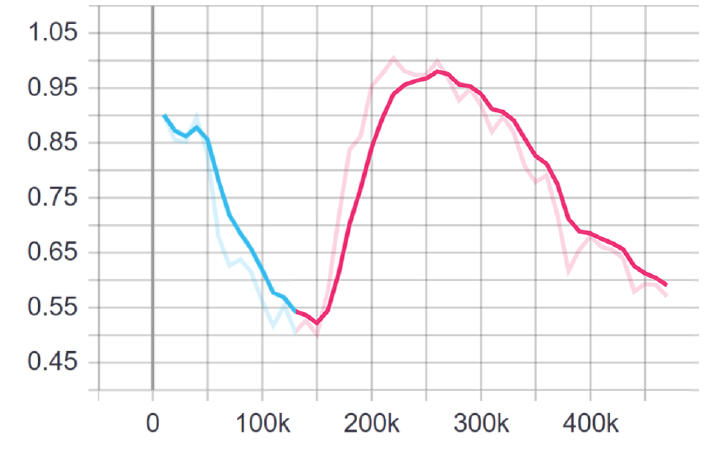
Figure 5. Entropy (Tensorboard).